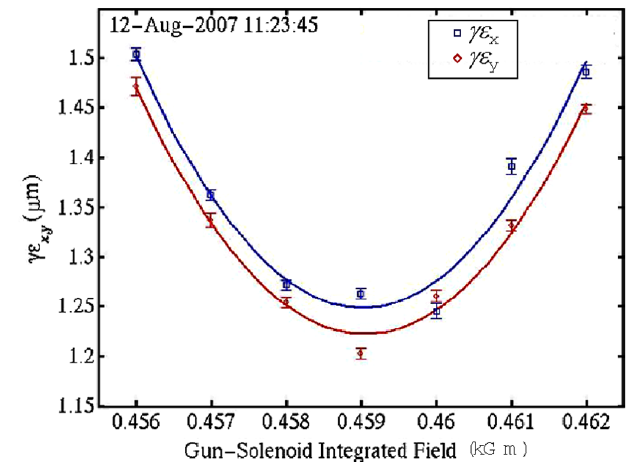
FIG. 31. (Color) Gun-solenoid field scan to minimize x (blue) and y (red) projected emittance at 135 MeVand 1 nC with a gun exit electron energy of 6.0 MeV. More typically the two minima are not so well aligned.